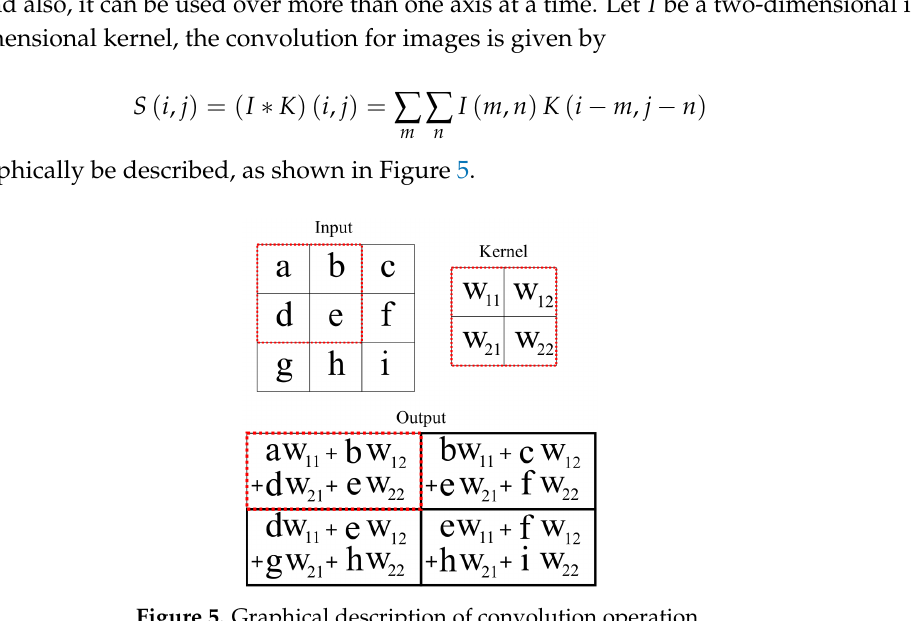
Figure 5. Graphical description of convolution operation.